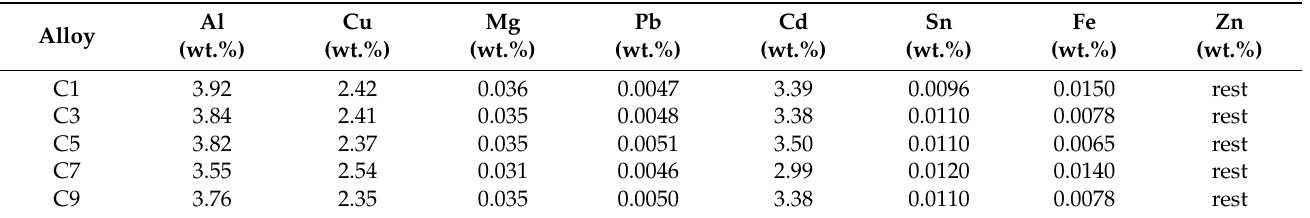
Table 5. Chemical composition of ZnAl4Cu3 alloy with Cd addition depending on the number of